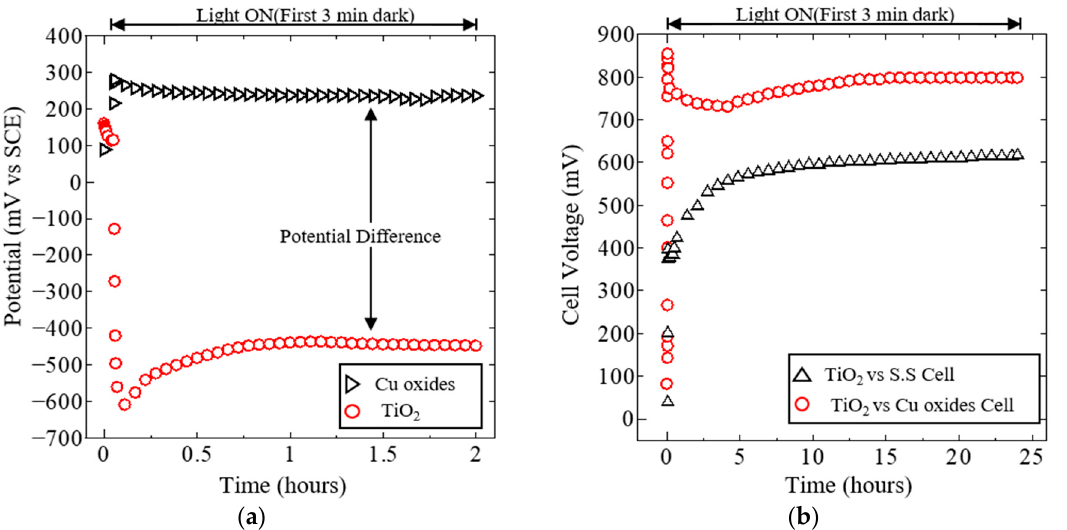
Figure 2. ( a ) Photopotential of the TiO 2 and copper oxides electrodes, and ( b ) cell voltage over a 24 h period of combined TiO 2 –Cu oxides cell and TiO 2 –stainless steel cell.